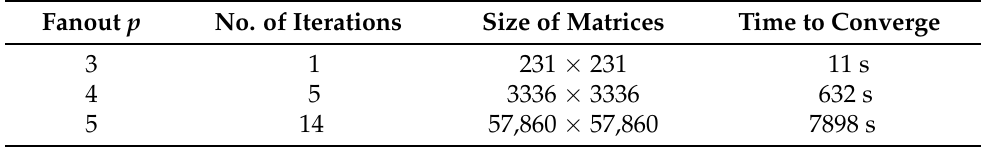
Table 4. Policy iteration